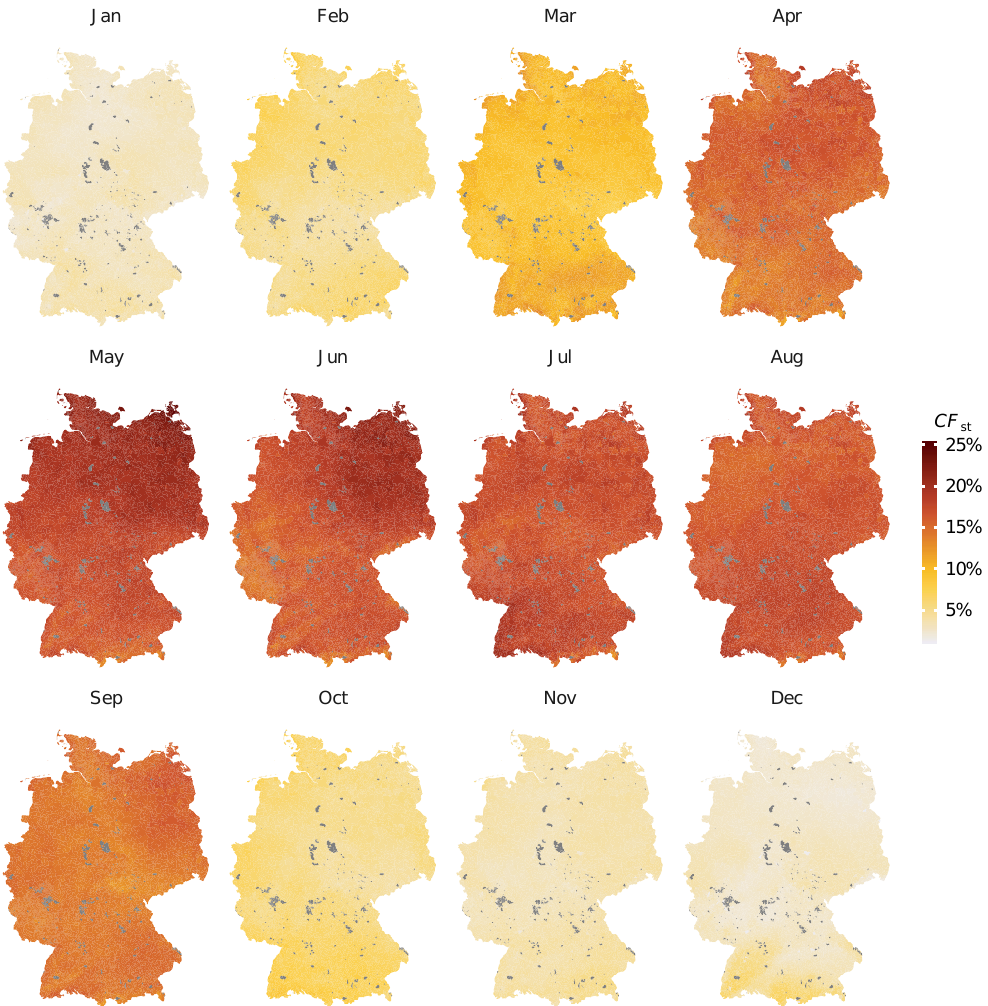
Figure 6. Calculated monthly capacity factors of PV systems at LAU2 level in Germany for 2016. In the dark grey areas no PV systems are installed.